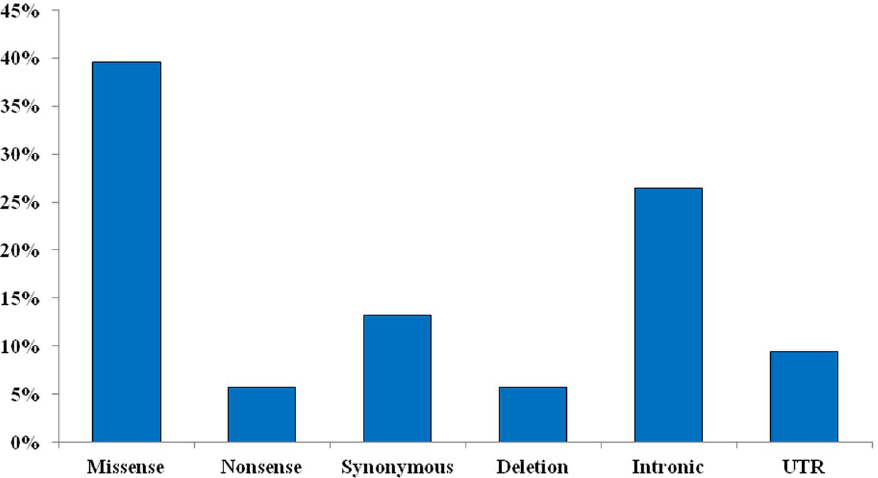
Figure 1. Total percentage of nucleotide changes found in this study for the analyzed genes. The variations that appear in greater proportion are missense, followed by those located in the intronic